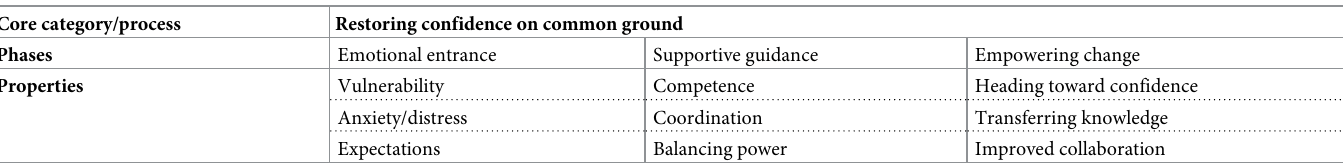
Table 1. Core category, phases and properties resulting from the analysis.